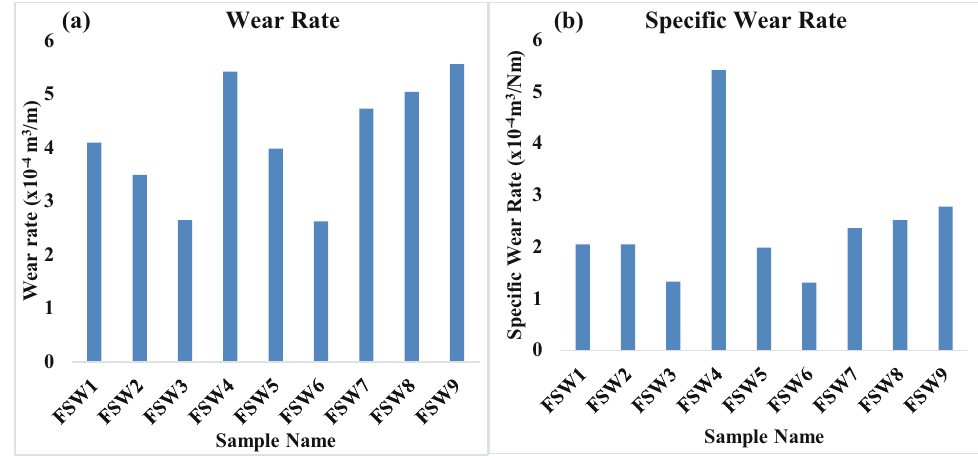
Figure 3: ( a ) Wear rates and ( b ) speci fi c rates of the samples.